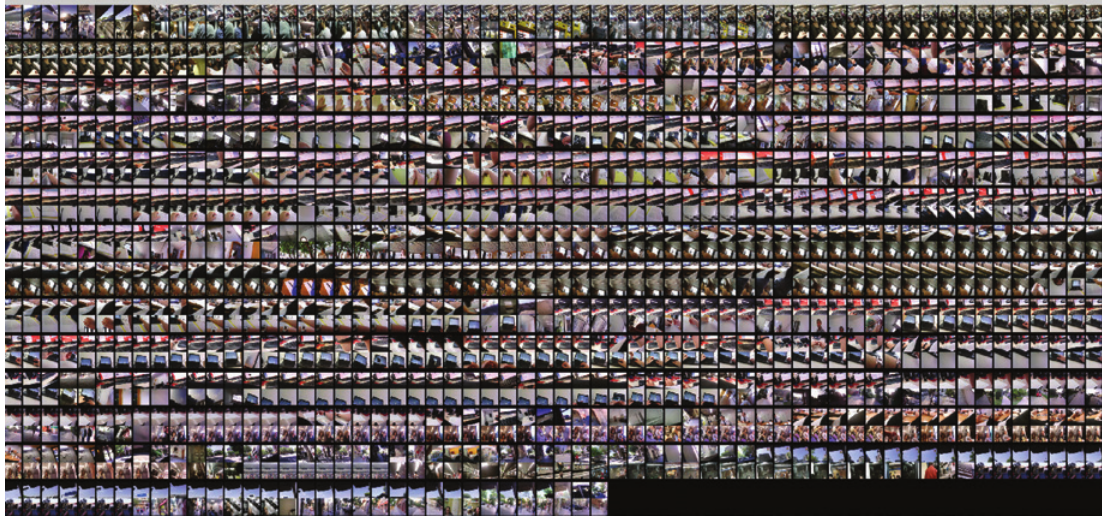
Figure 7: Full example of similarity between days 6 and 8.